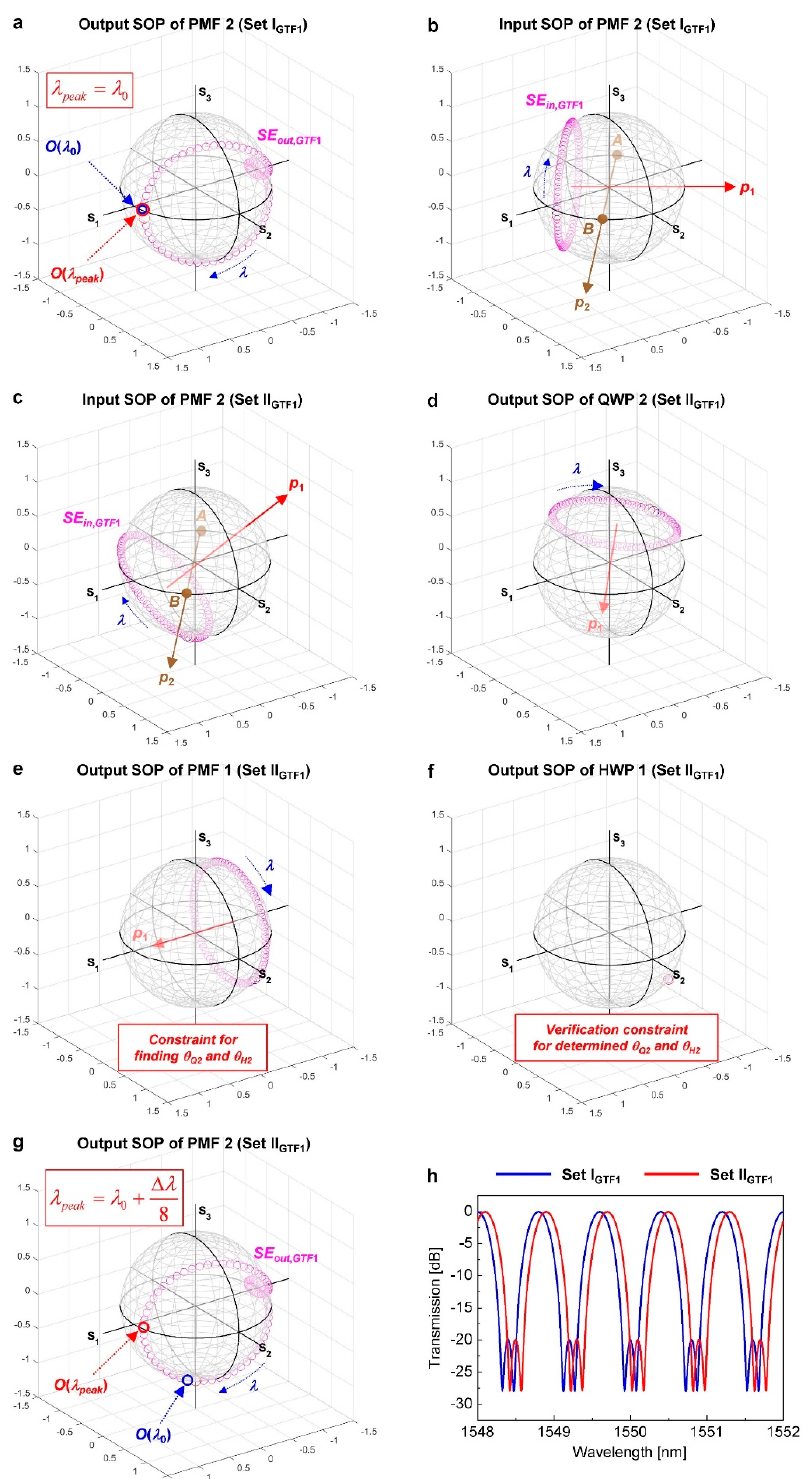
Figure 3. Wavelength-dependent variation of SOP’s in t GTF 1 obtained at Set I GTF1 : ( a ) SOP out and ( b ) SOP in traces of PMF 2 at Set I GTF1 . Spectral evolution of SOP’s in the phase-modulated version of t GTF 1 , obtained at Set II GTF1 : ( c ) SOP in trace of PMF 2, ( d ) SOP out trace of QWP 2, ( e ) SOP out trace of PMF 1, ( f ) SOP out of HWP 1, and ( g ) SOP out trace of PMF 2. ( h ) Two calculated transmission spectra obtained at Sets I GTF1 and II GTF1 , indicated as blue and red solid lines,